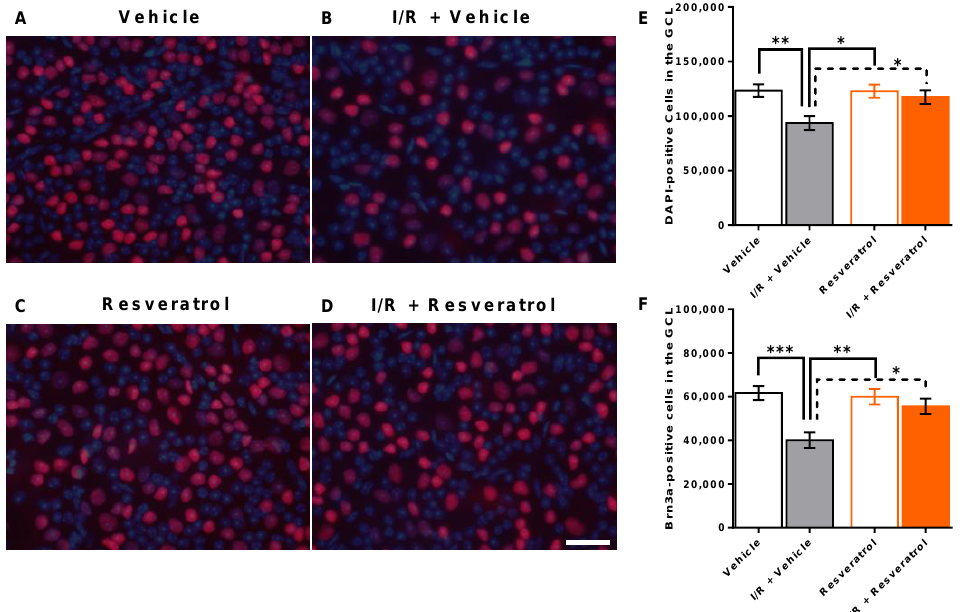
Figure 1. Cells in the ganglion cell layer (GCL) of the retina. ( A – D ) Representative pictures of cells in the ganglion cell layer stained with DAPI (blue color) to determine total cell number and with an antibody directed against Brn3a, a specific marker for retinal ganglion cells, together with an Alexa Fluor 568 secondary antibody (red color). Scale bar = 30 µ m. I/R markedly reduced total cell number ( E ) and ganglion cell number in the retinal GCL ( F ) in vehicle-treated mice but not in resveratrol-treated mice. Values are expressed as means ± SE (*** p < 0.001; ** p < 0.01; * p < 0.05; n = 8 per